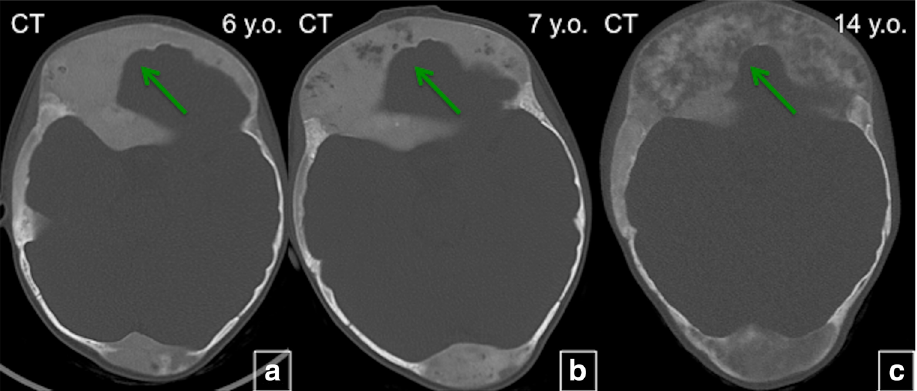
Fig. 13 Age-related changes in fibrous dysplasia (FD). CT of the head on the same patient at age of 6 ( a ), 7 ( b ) and 14 years ( c ). Diffuse FD involvement with homogenous “ ground glass ” appearance ( green arrows ), which demonstrates the tendency to develop cystic lesions and become more heterogeneous with time ( green arrows